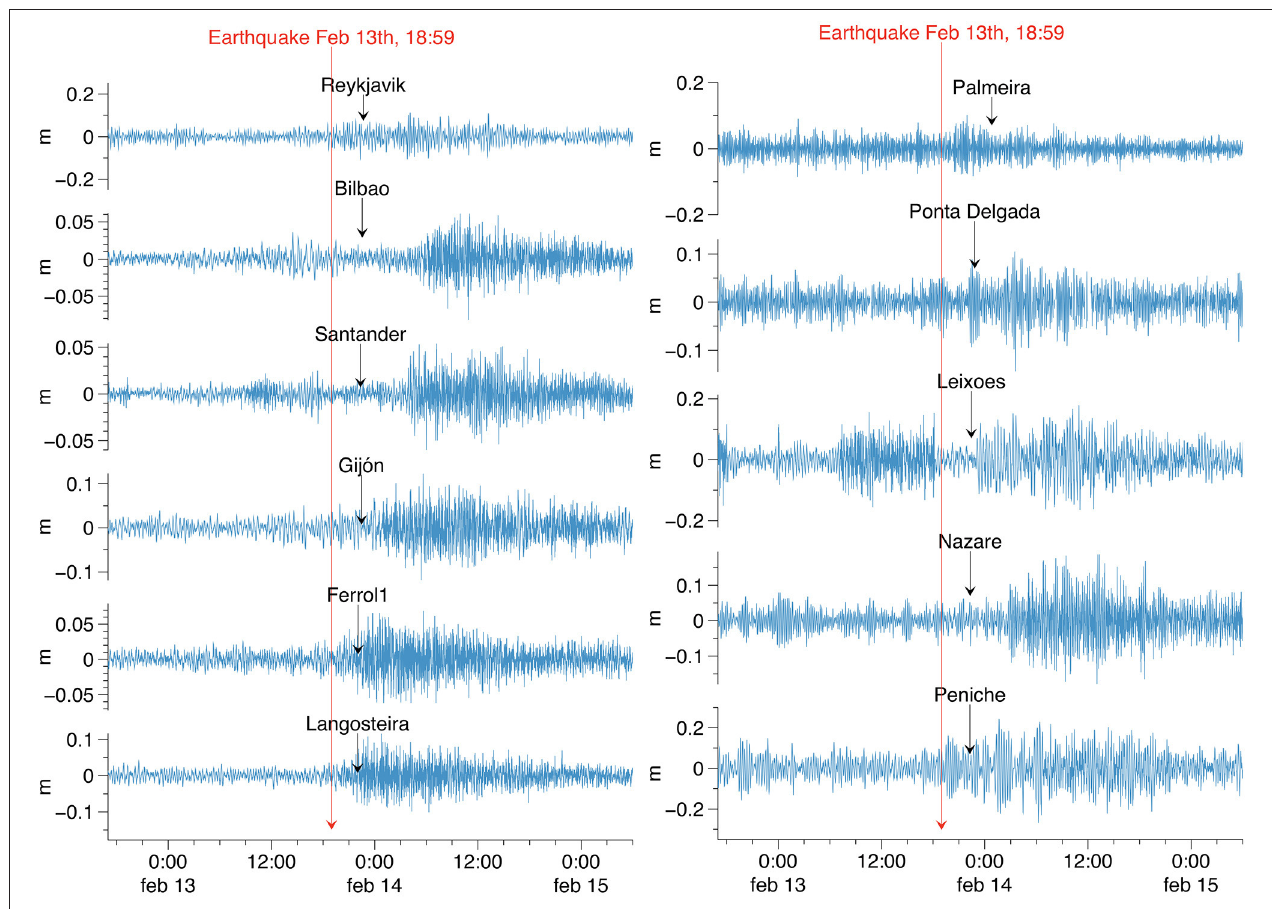
FIGURE 11 | 1 min high-pass filtered sea level time series from those stations on Figure 10 where a signal, even if small, might be present after the earthquake of February 13th 2015 showing the expected arrival times in Table 2, derived from the tsunami propagation model, at each tide gauge (black arrows). The earthquake time is indicated by the red